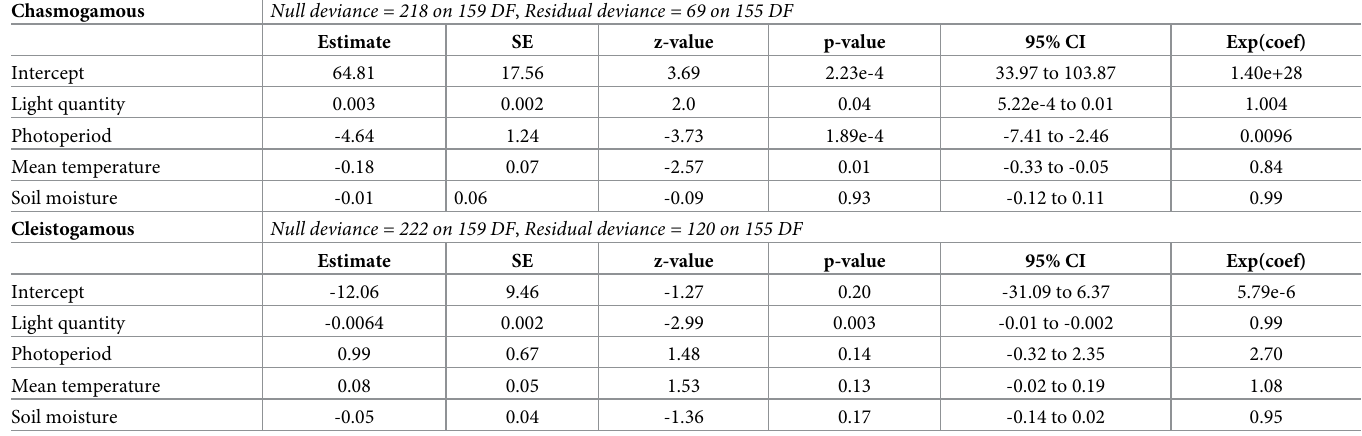
Table 3. Results of the binary logistic regressions predicting the odds of chasmogamous and cleistogamous buds developing as a function of the averaged environ- mental variables.